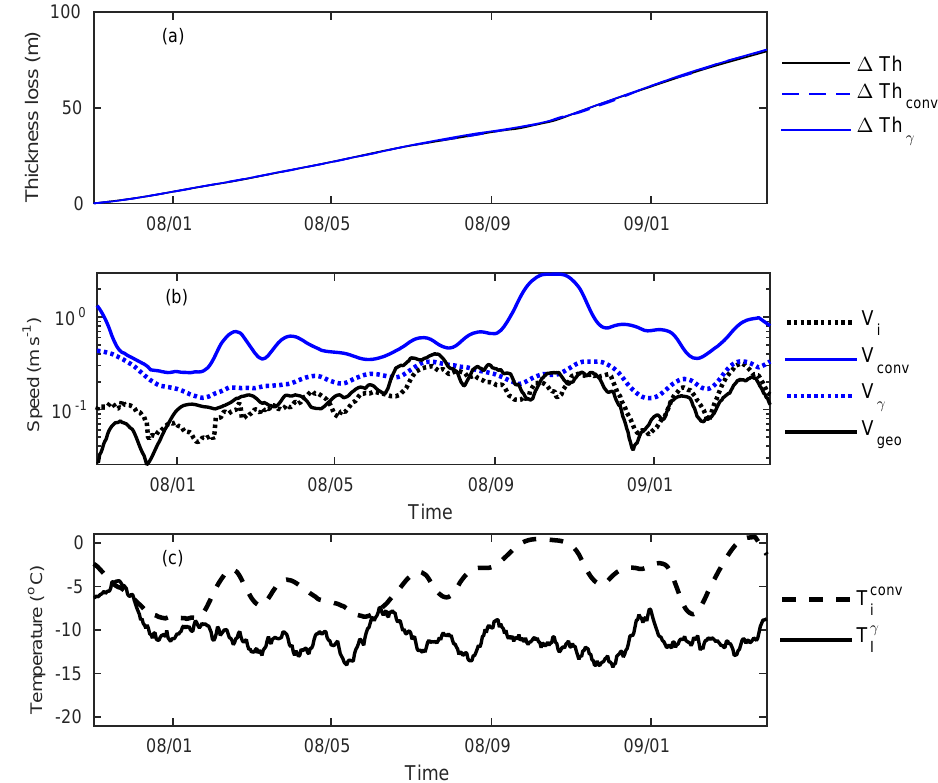
Figure 7. Thickness loss (in m) for C19a (a) . Measured thickness loss (black line); modelled loss using forced convection (dashed blue line) and turbulent exchange (solid blue line). (b) Iceberg velocity (dotted black line). Modelled velocity using forced convection (solid blue line) and using turbulent exchange (dotted blue line). AVISO Geostrophic current velocity (solid black line). (c) Modelled iceberg temperature using forced convection (dashed line) and using thermal exchange (solid